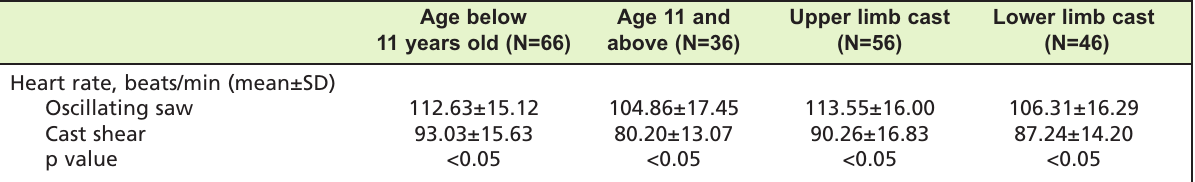
Comparison of heart rate between oscillating saw and cast shear group according to different age group and Table III: location of cast, during the procedure